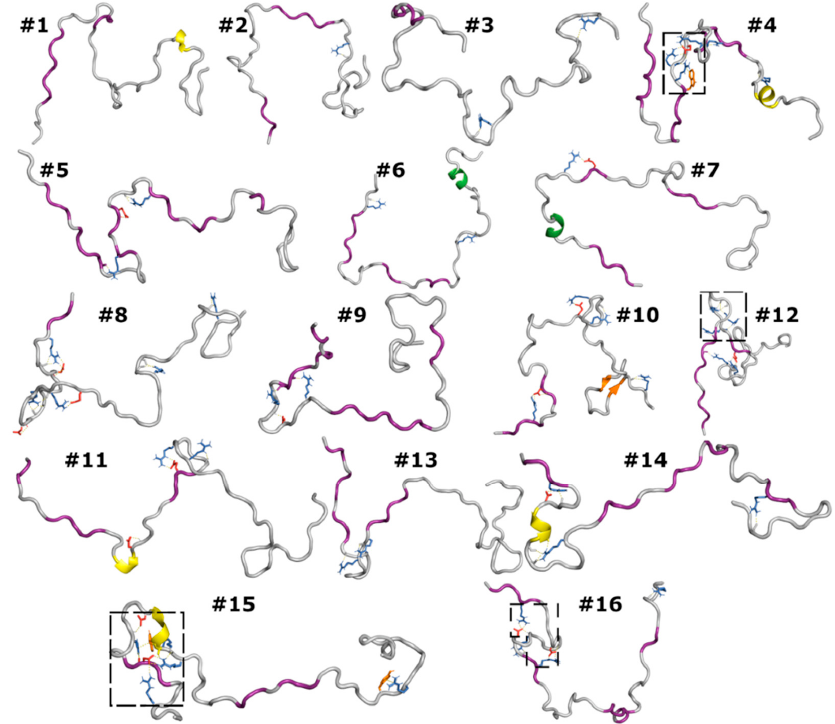
Figure 4. Representative conformations from the MD simulations. Secondary structures are shown by the color of the backbone (PPII, 3 10 , and hybrid 3 10 - α helices in purple, yellow, and green respectively; β -sheet, orange). Cationic, anionic, and aromatic side chains involved in salt bridges, cation– π interactions, and SC-BB hydrogen bonds are shown in blue, red, and orange, respectively. Boxed regions, after enlargement, are shown in Figure 5.